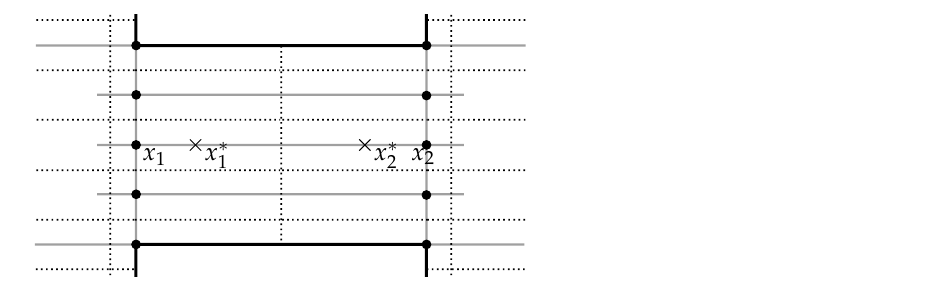
Figure 5. Nodes in orifice region ( x 1 to x 2 ) with their cell volumes, where the centroid of the cell volume.